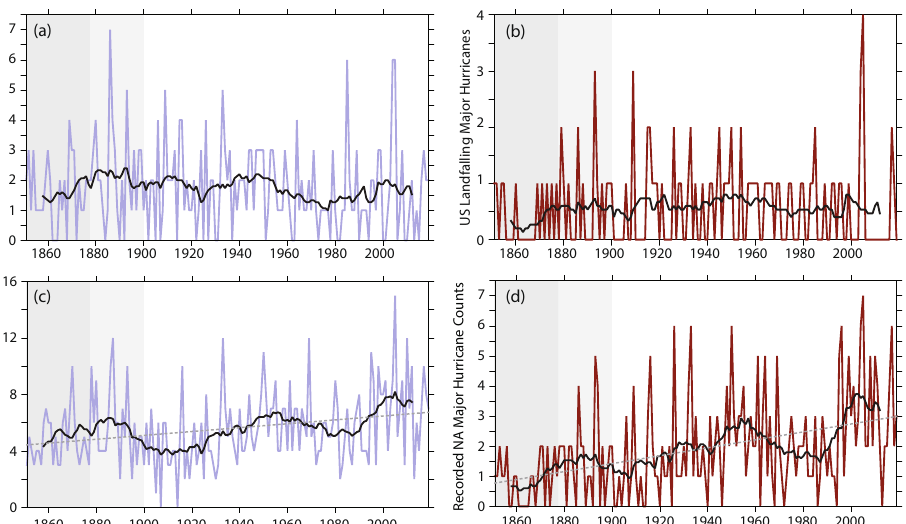
Fig. 1 Recorded USA hurricane strikes and basin-wide frequency. Time-series of annual (colored lines) and 15-year running average (black lines) count of hurricanes (panels a and c ; maximum wind speed ≥ 33 ms − 1 ) and major hurricanes (panels b and d ; maximum wind speed ≥ 50 ms − 1 ) either striking the mainland United States of America (USA; panels a and b ) or in the whole North Atlantic basin (panels c and d ) from version 2 of the North Atlantic Hurricane Database (HURDAT2, ref. 33 ). Dark gray background shading between 1851 – 1877 indicates the period before the United States Signal Corps was tasked with recording all tropical cyclones in the North Atlantic (ref. 35 ), light gray background shading between 1878 and 1900 indicates the time before which it is estimated that all hurricanes striking the USA would have been recorded (ref. 36 ). Table 1 Measures of secular change in hurricane frequency.